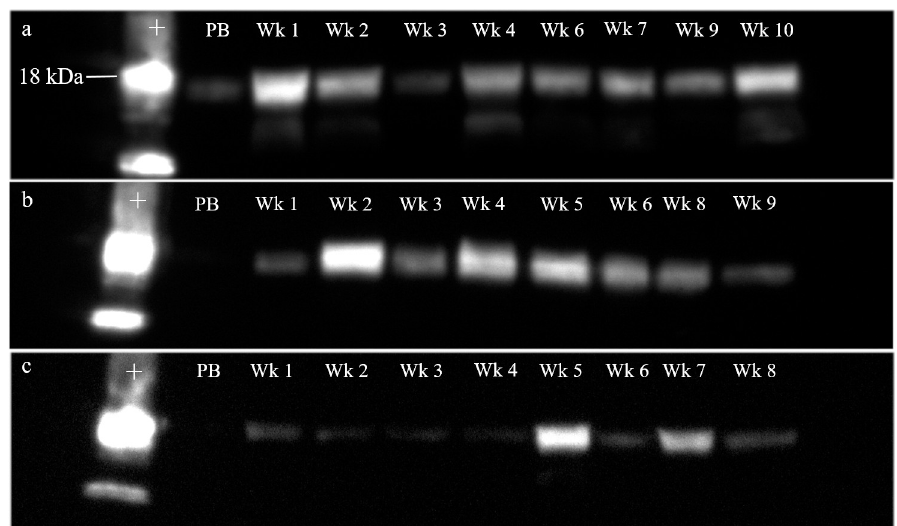
Fig 2. IgJ response immediately following breeding in the cheetah. (a) A female (#6592) that was bred naturally with an intact male had high IgJ levels in week 1 and week 2 post-breeding. (b) A female (#6462) that was bred naturally with an intact male had high IgJ levels in week 2 post-breeding. (c) A female (#8957) with no exposure to a male following exogenous stimulation to ovulate did not experience an increase in IgJ levels in weeks 1 or 2 following breeding. Positive control is denoted by “+.” Pre-breeding sample is denoted by “PB”.